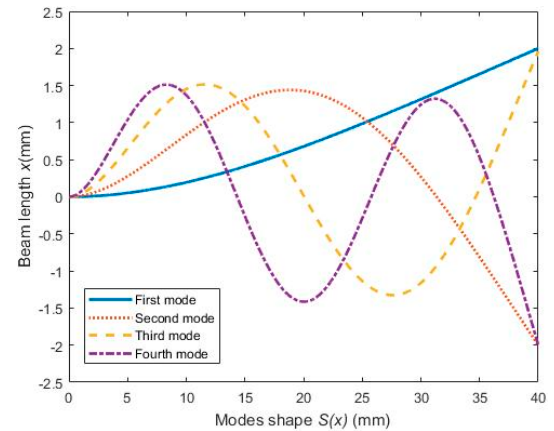
Figure 4. The modes shape of the beam.